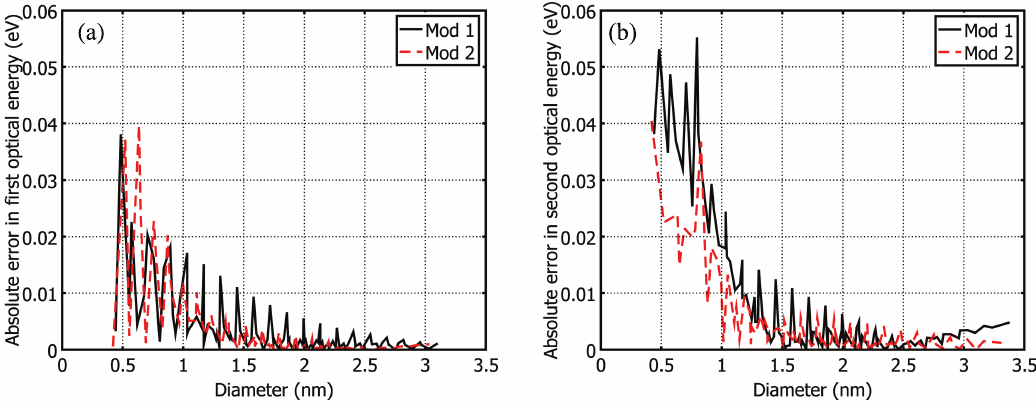
Figure 2. Plot of absolute deviations (errors) of first ( E transition energy vs . nanotube diameter ( d experimental data for both mod 1 and mod 2; ( b ) Absolute deviations of empirical E experimental data for both mod 1 and mod 2.